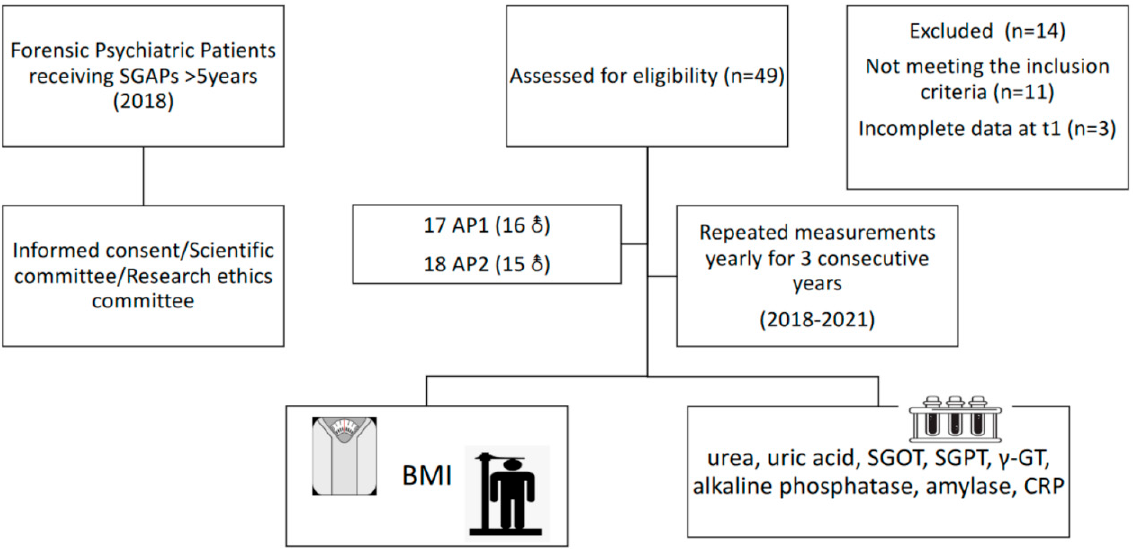
Figure 1. Flow chart of the prospective study.